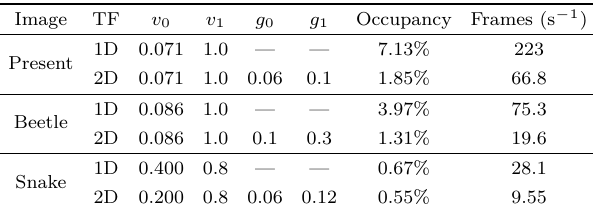
Table 2 Unaccelerated baseline frame rates for each image with a 1D and 2D transfer function (TF). Images are rendered to a 1200 ×